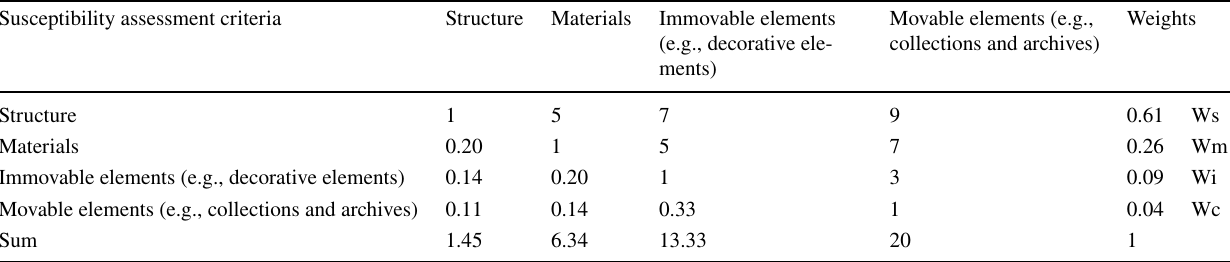
Ws weight of structure, Wm weight of materials, Wi weight of immovable elements, Wc weight of movable Table 4 Pairwise comparison of the significance of components contributing to the overall susceptibility to slow-onset hazards